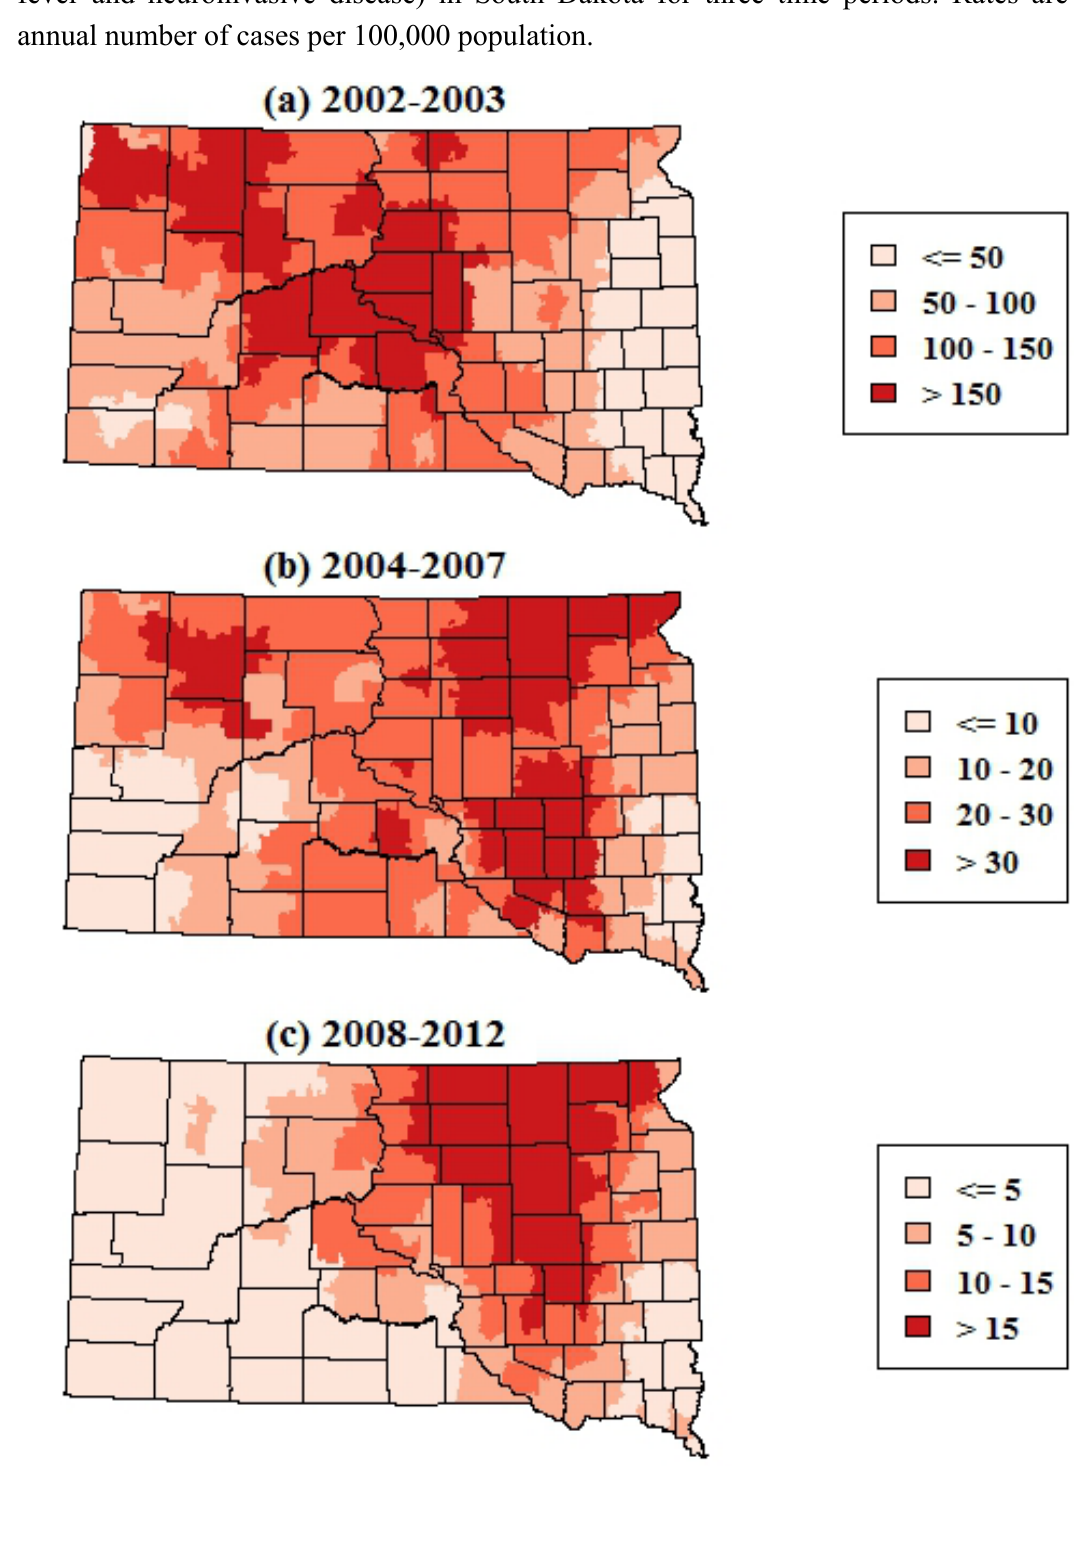
Figure 3. Spatially smoothed incidence rates of all human WNV disease (including both fever and neuroinvasive disease) in South Dakota for three time periods. Rates are the annual number of cases per 100,000